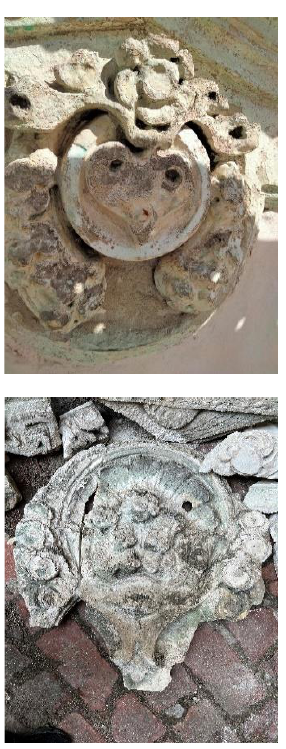
Figure 11. Traditional method of restoration of two ornaments, from the original piece to different stages of the reconstruction and the final pieces of Lajos (Ludwig) Besch and Károly (Karl) Piffl Palace ornaments.